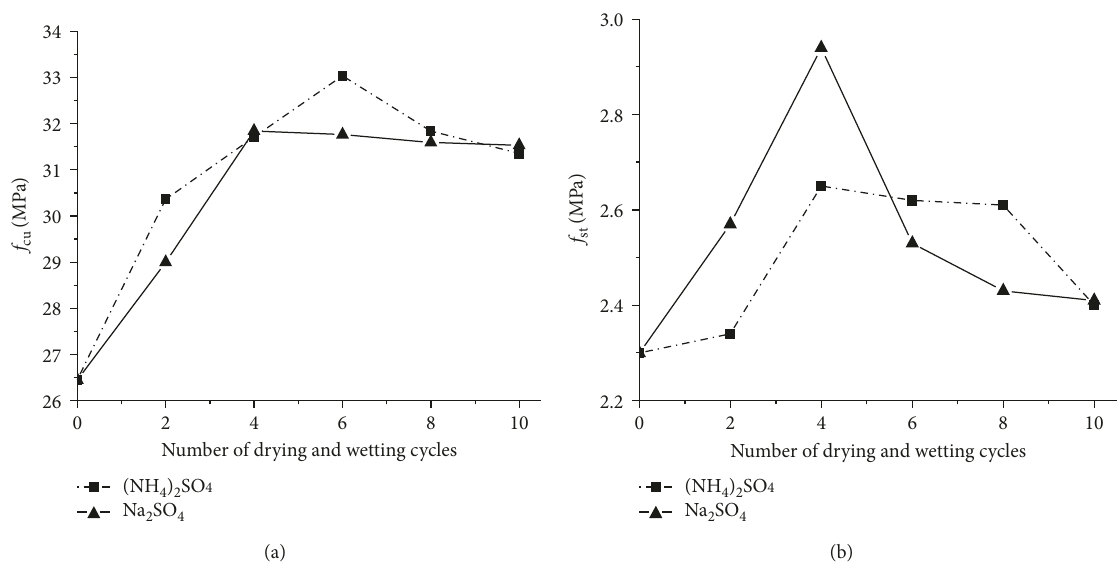
Figure 3: Changes in the strengths of corroded fly ash concrete varied to dry-wet cycles. (a) Compressive strength. (b) Splitting tensile